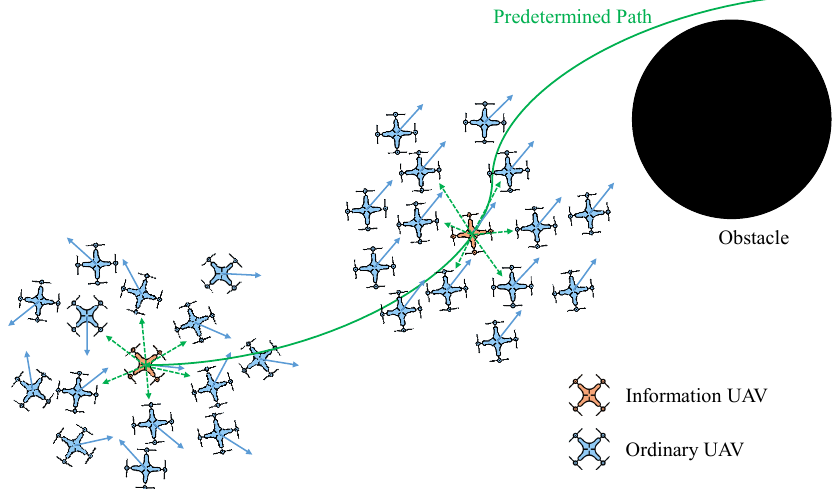
Figure 1. The scenario of flocking navigation with obstacle avoidance. The Information UAV (the red UAV) adjusts its heading angle according to the predetermined path information it learns in advance. The objective of this paper is to make sure that all the blue UAVs follow the red one closely and avoid the obstacle